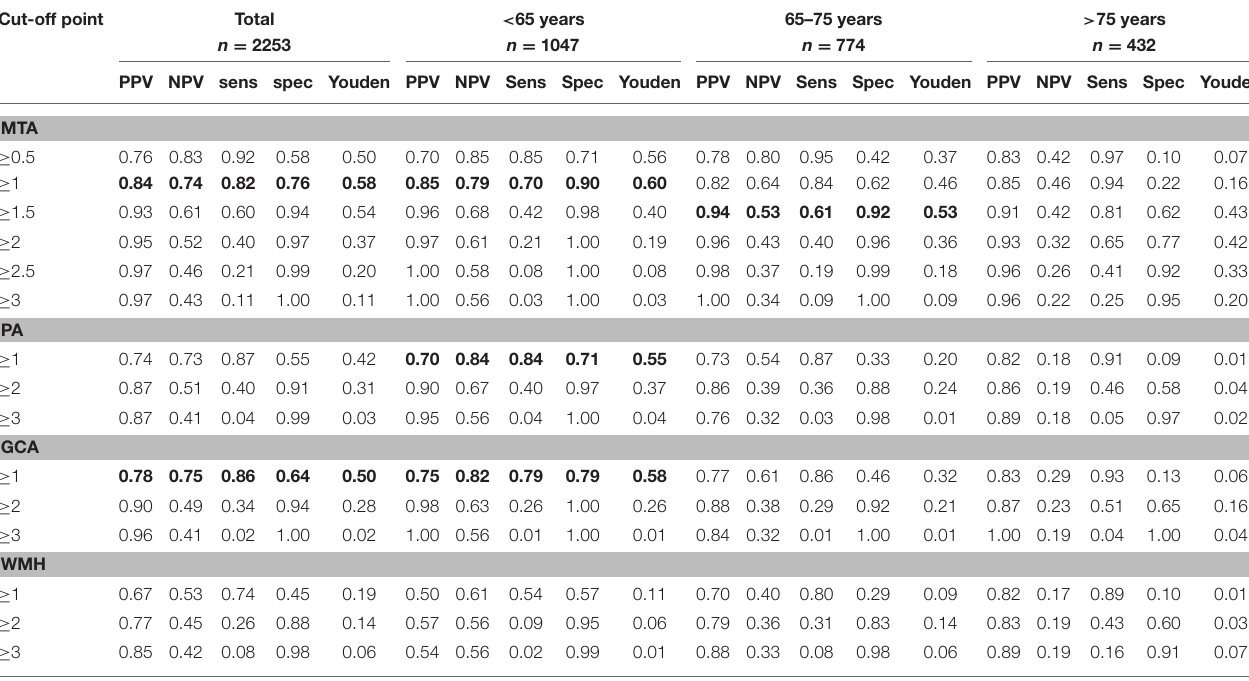
TABLE 4 | Discriminatory value of different cut-off points of MTA, PA, GCA, and WMH for differentiating AD from controls in total population and in three age groups. Cut-off point